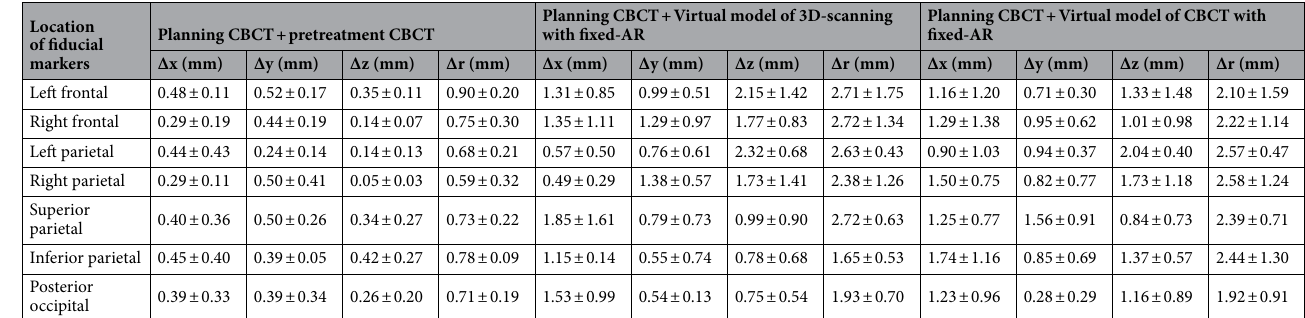
Table 2. The mean errors of fiducial marker coordinates in virtual models with fixed-AR. The mean error of fiducial markers is calculated by CBCT scanning coordinates (X,Y,Z). All data are shown as mean ± standard